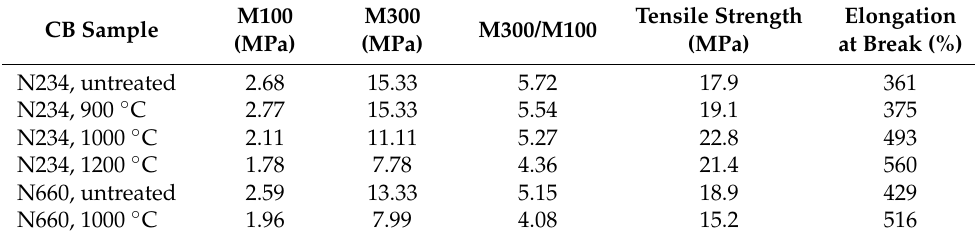
Table 4. Effects of CB Heat Treatment on Tensile Properties of CB-Filled